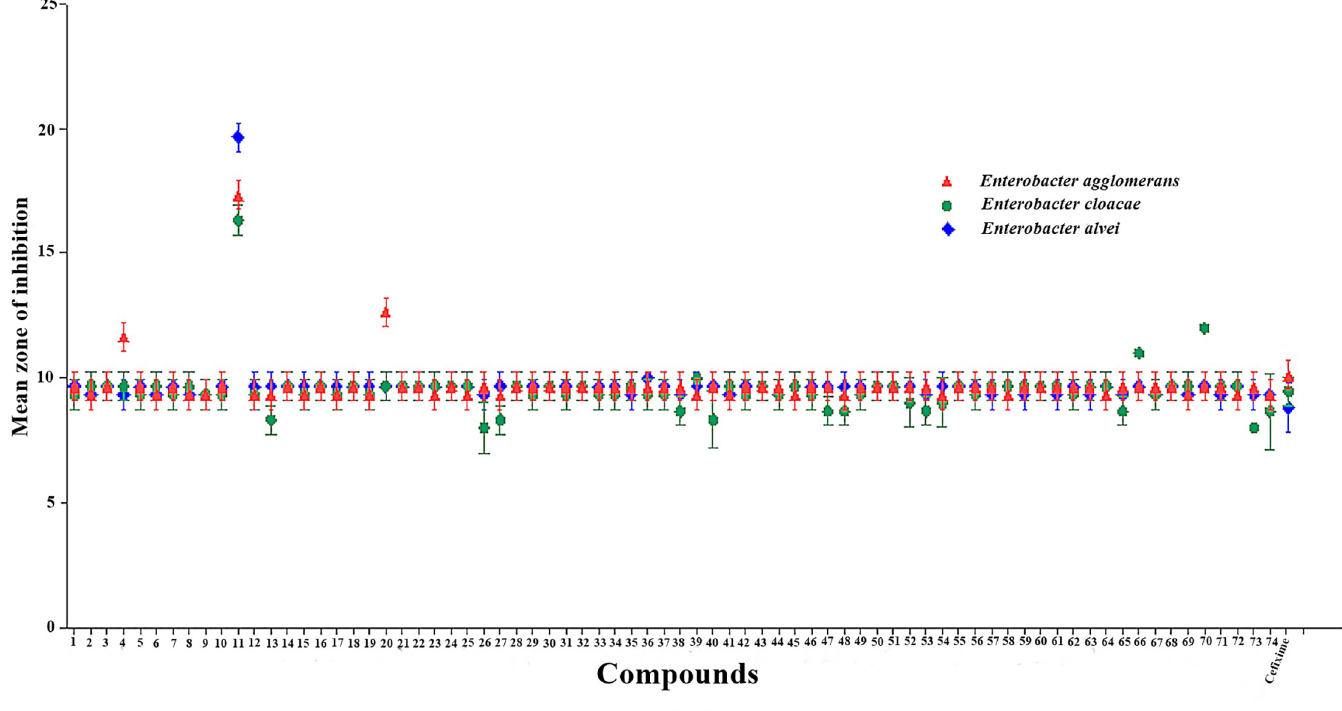
Fig 7. Graphical representation of synergetic effect of the computationally screened compounds-cefixime with positive control.